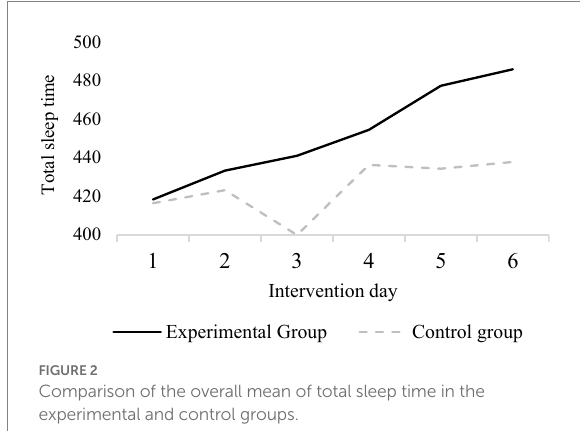
FIGURE 2 Comparison of the overall mean of total sleep time in the experimental and control groups.